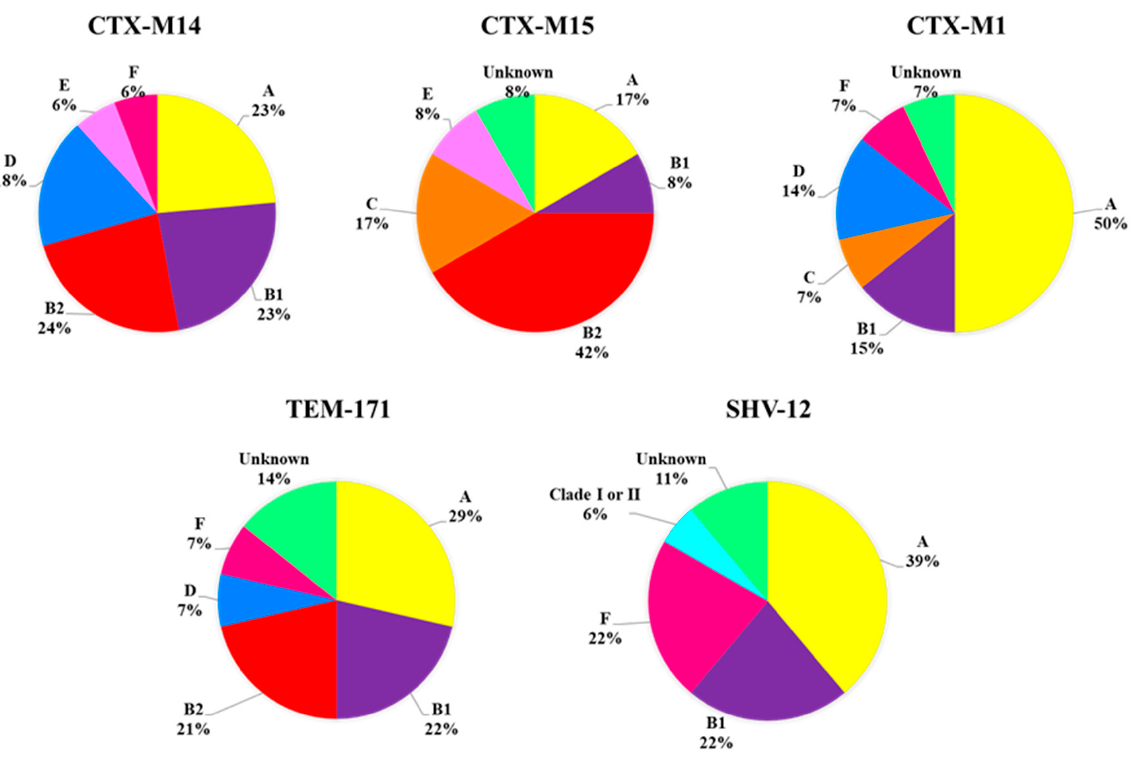
Figure 2. Distribution of E. coli strains producing different types of ESBLs within the phylogenetic groups.